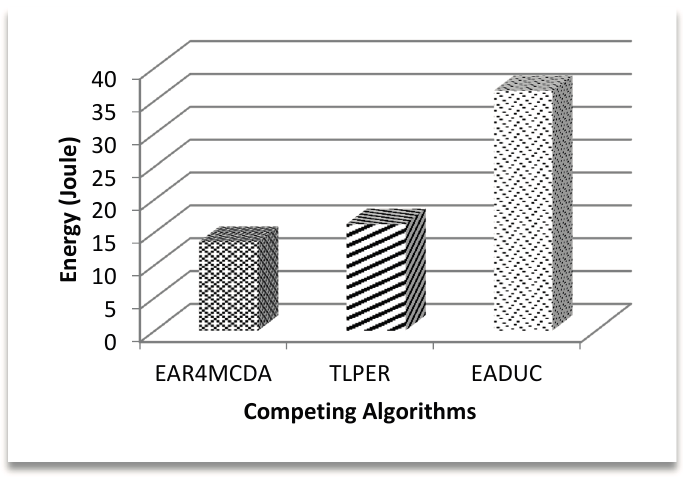
Figure 15. Energy consumption for cluster head